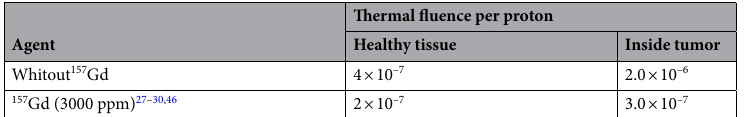
Table 5. Reduction amount of the secondary neutrons in energy range of thermal to 1 keV. The fluence (per proton) inside and outside the tumor has been measured and compared to the fluence when 3000 ppm of gadolinium-157 has been